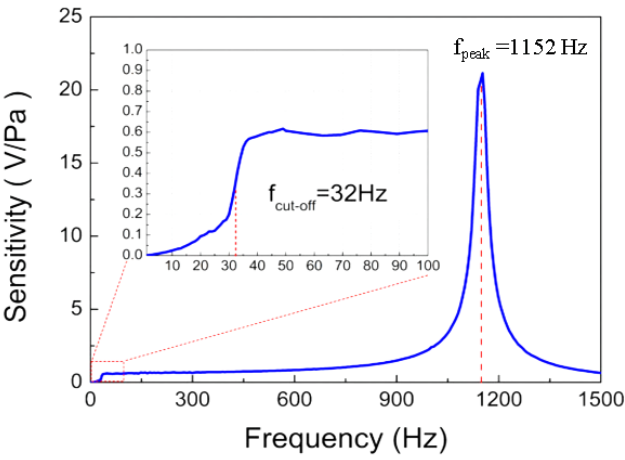
Figure 8. Frequency responses of the fiber-optic microphone (inset: an enlarged view of the low-frequency regime).